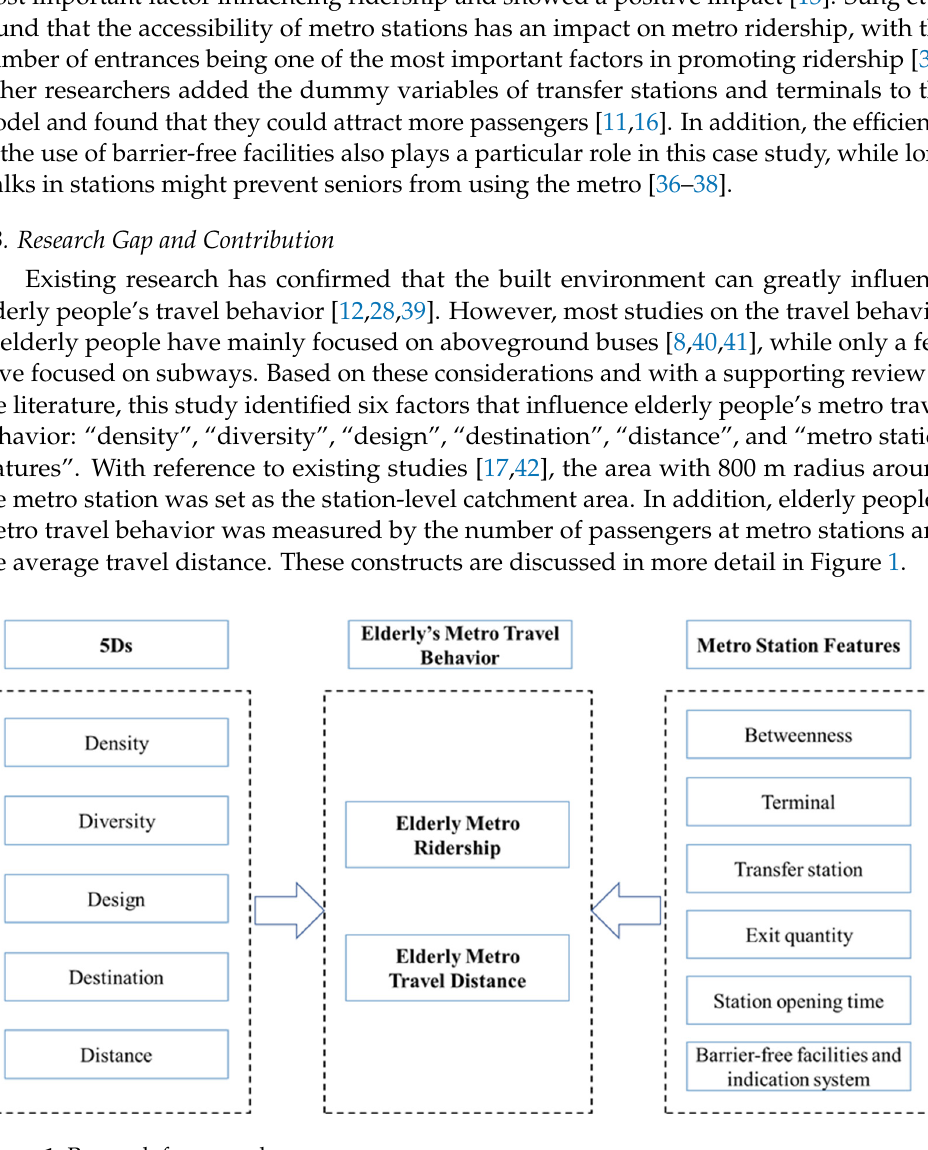
Figure 1. Research